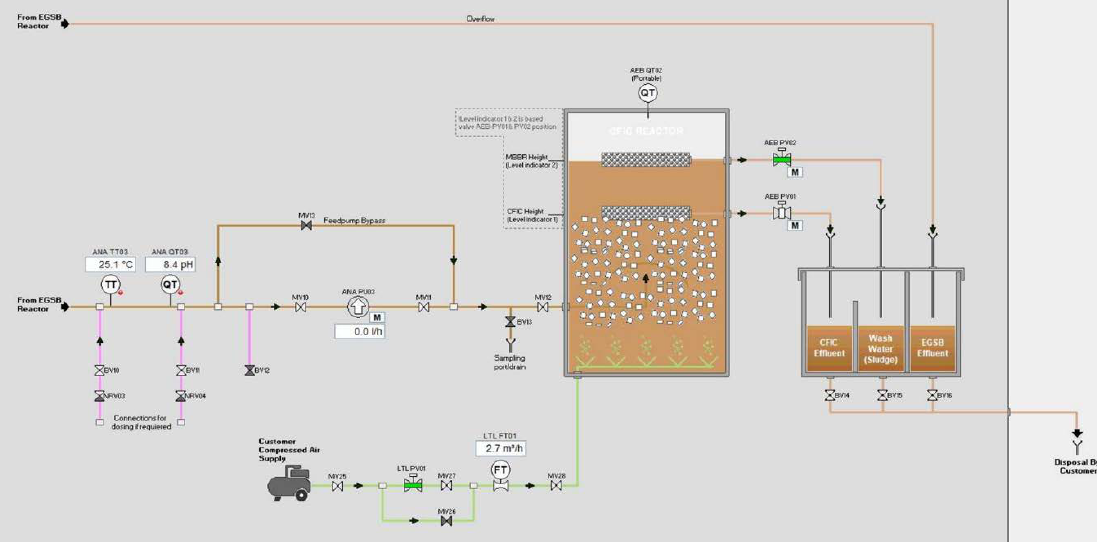
Figure 5. CFIC reactor control and effluent collection.